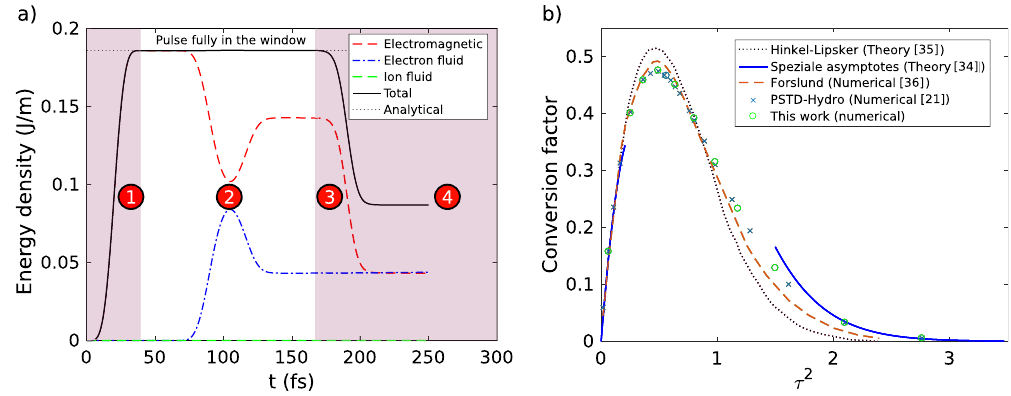
Figure 6. ( a ) Evolution of electromagnetic energy, fluid energy, and total energy as function of time for p-polarized incident pulse. In the central white area, the pulse is fully enclosed within the numerical window and the conservation of the total energy is preserved. ( b ) Mode conversion factor as a function of 2 / 3 sin 2 2 π L θ . Green circles are our numerical results with PSATD/Hydrodynamic code. Results from τ 2 = (cid:31) (cid:30) (cid:31) others references are shown for comparison: Hinkel-Lipsker analytical model (dotted black line) 35 , Speziale asymptotes (solid blue lines) 34 , Forslund PIC simulations 36 (dashed orange line) and PSTD/Hydrodynamic (Blue crosses) 21